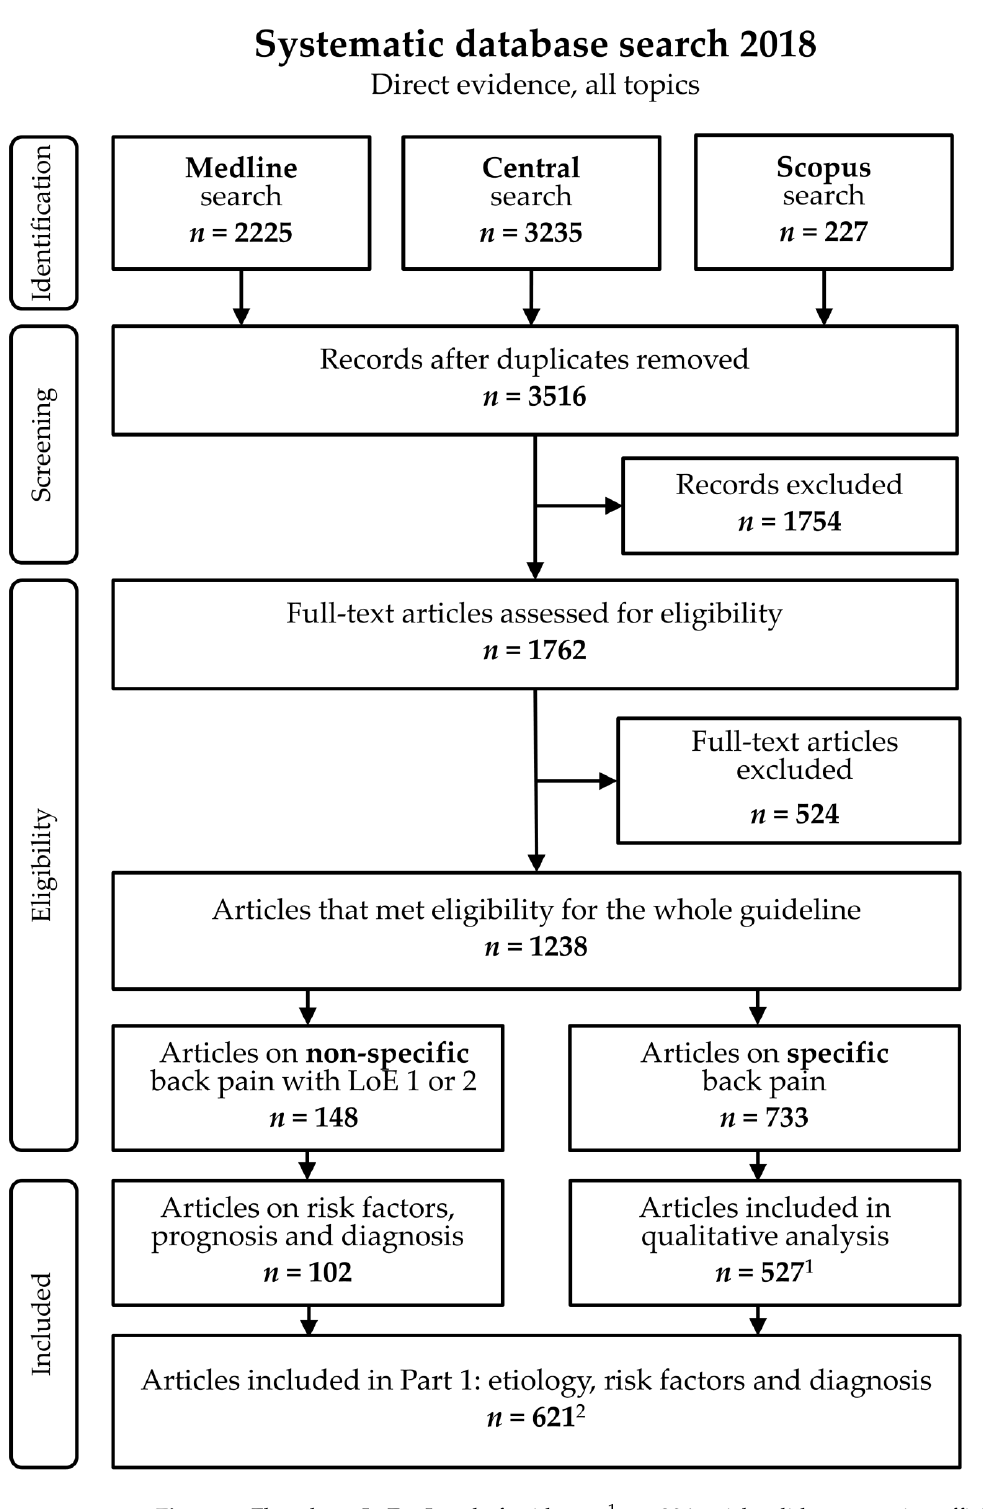
Figure 1. Flowchart. LoE = Level of evidence. 1 n = 206 articles did not contain sufficient